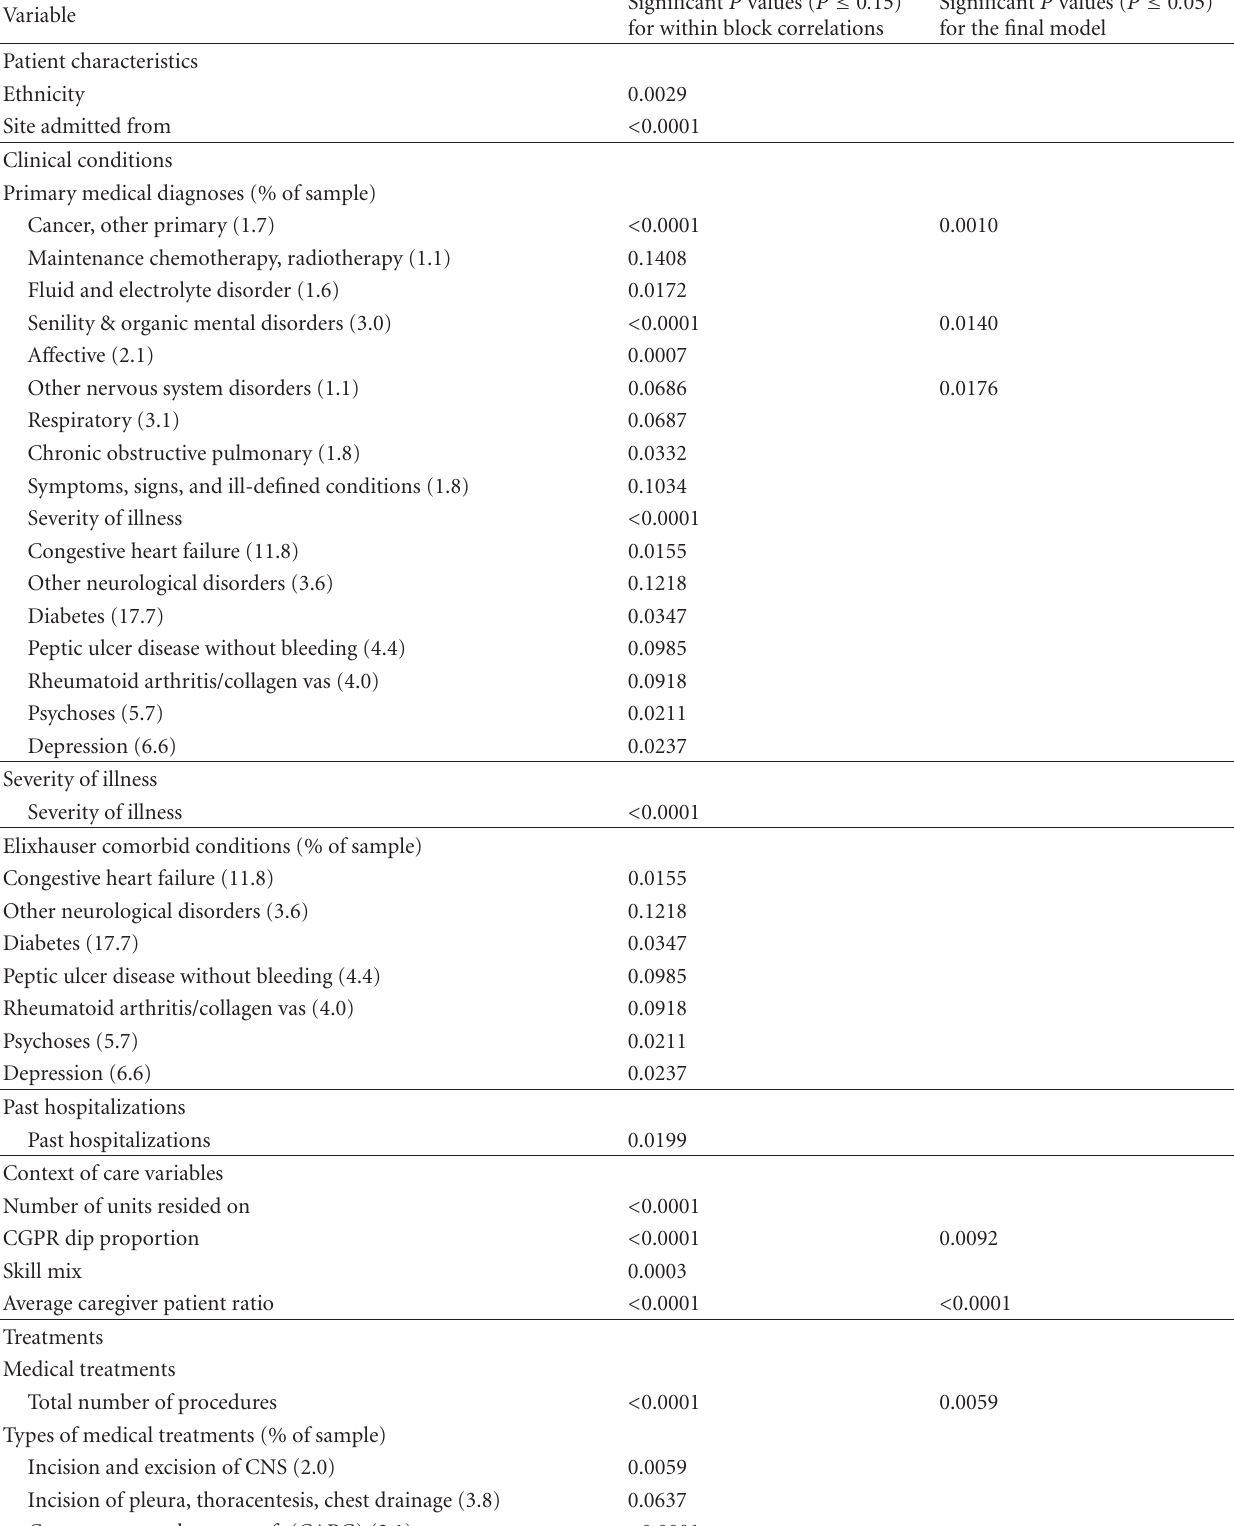
Table 2: Results from the model building process for determining explanatory variables of experiencing an adverse